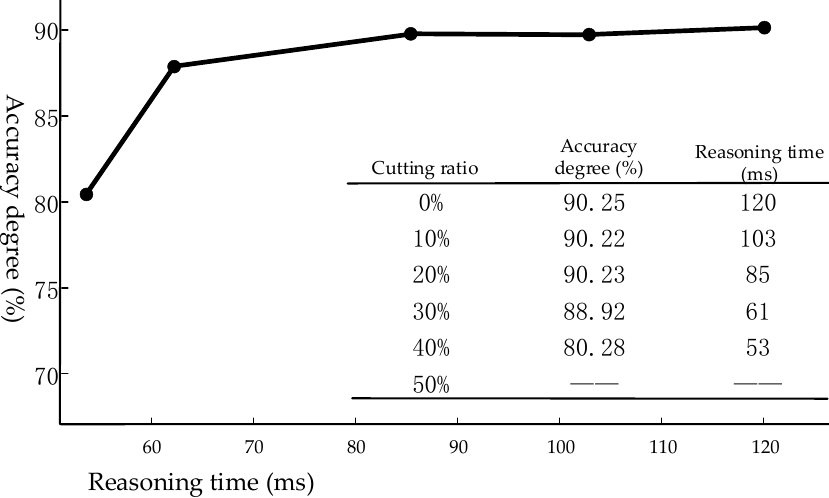
Figure 18. Comparison of experimental results for different cutting ratios .